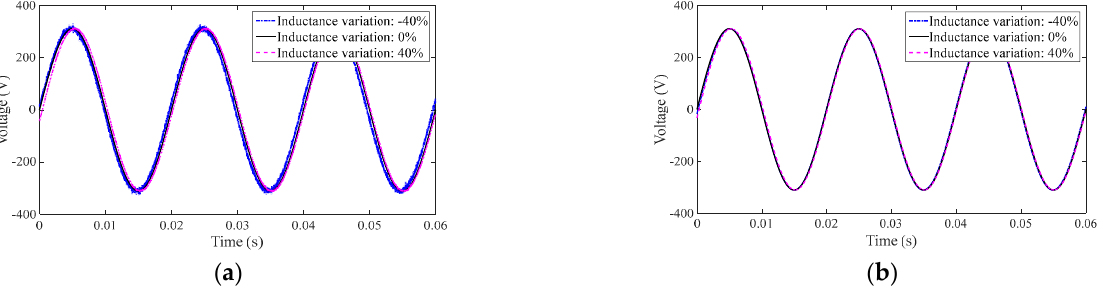
Figure 7. The output voltages of two voltage controllers: ( a ) output response of System 1 and ( b ) output response of System 2.